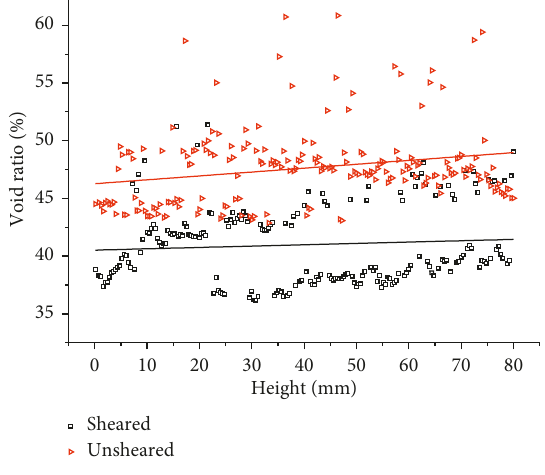
Figure 9: Void ratio variation with height.